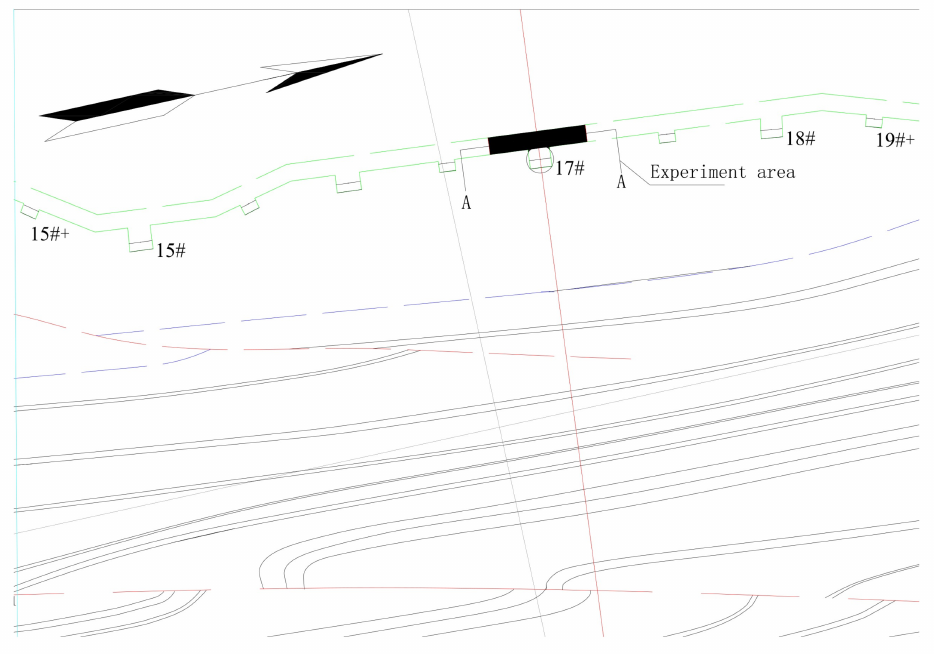
Figure 15. Extraction of roadway